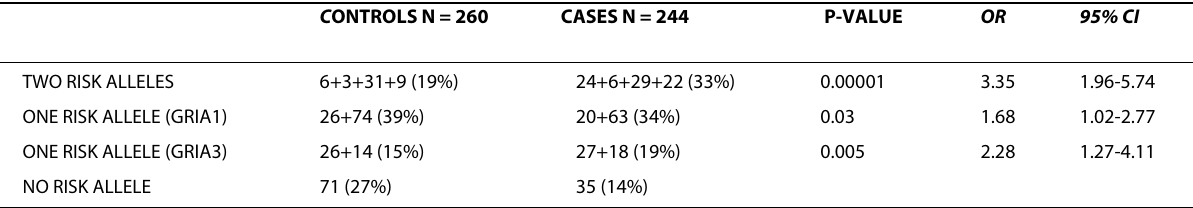
Table 4: Combined genotypic frequencies of GRIA1 (CT) and GRIA3 (TC) C ONTROLS N =